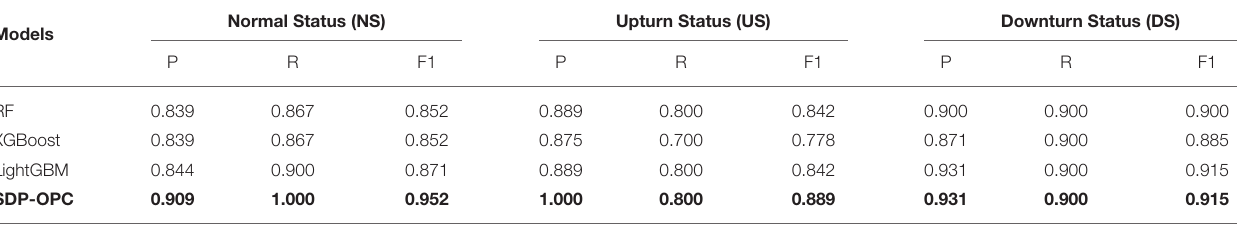
TABLE 8 | The classifier prediction performance by different company statuses. Models